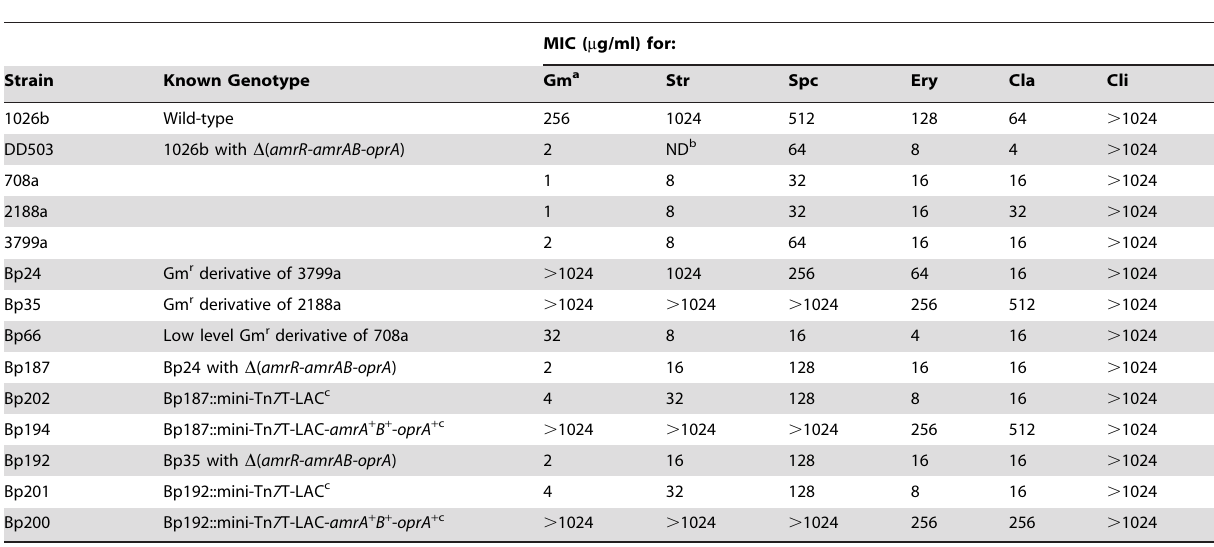
Table 3. Antibiotic susceptibilities of B. pseudomallei strains.